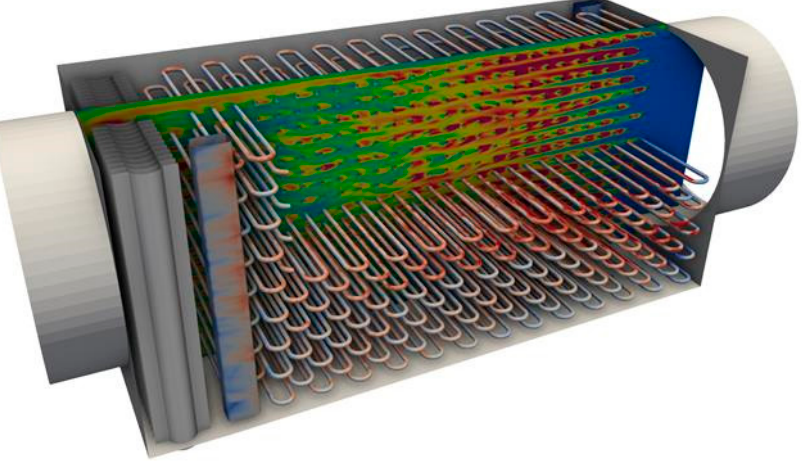
Figure 3. Visualization of turbulence intensity (cross-section) and heat flux (tubes) in a tube bundle heat exchanger (from blue—lowest value, to red—highest value respectively).